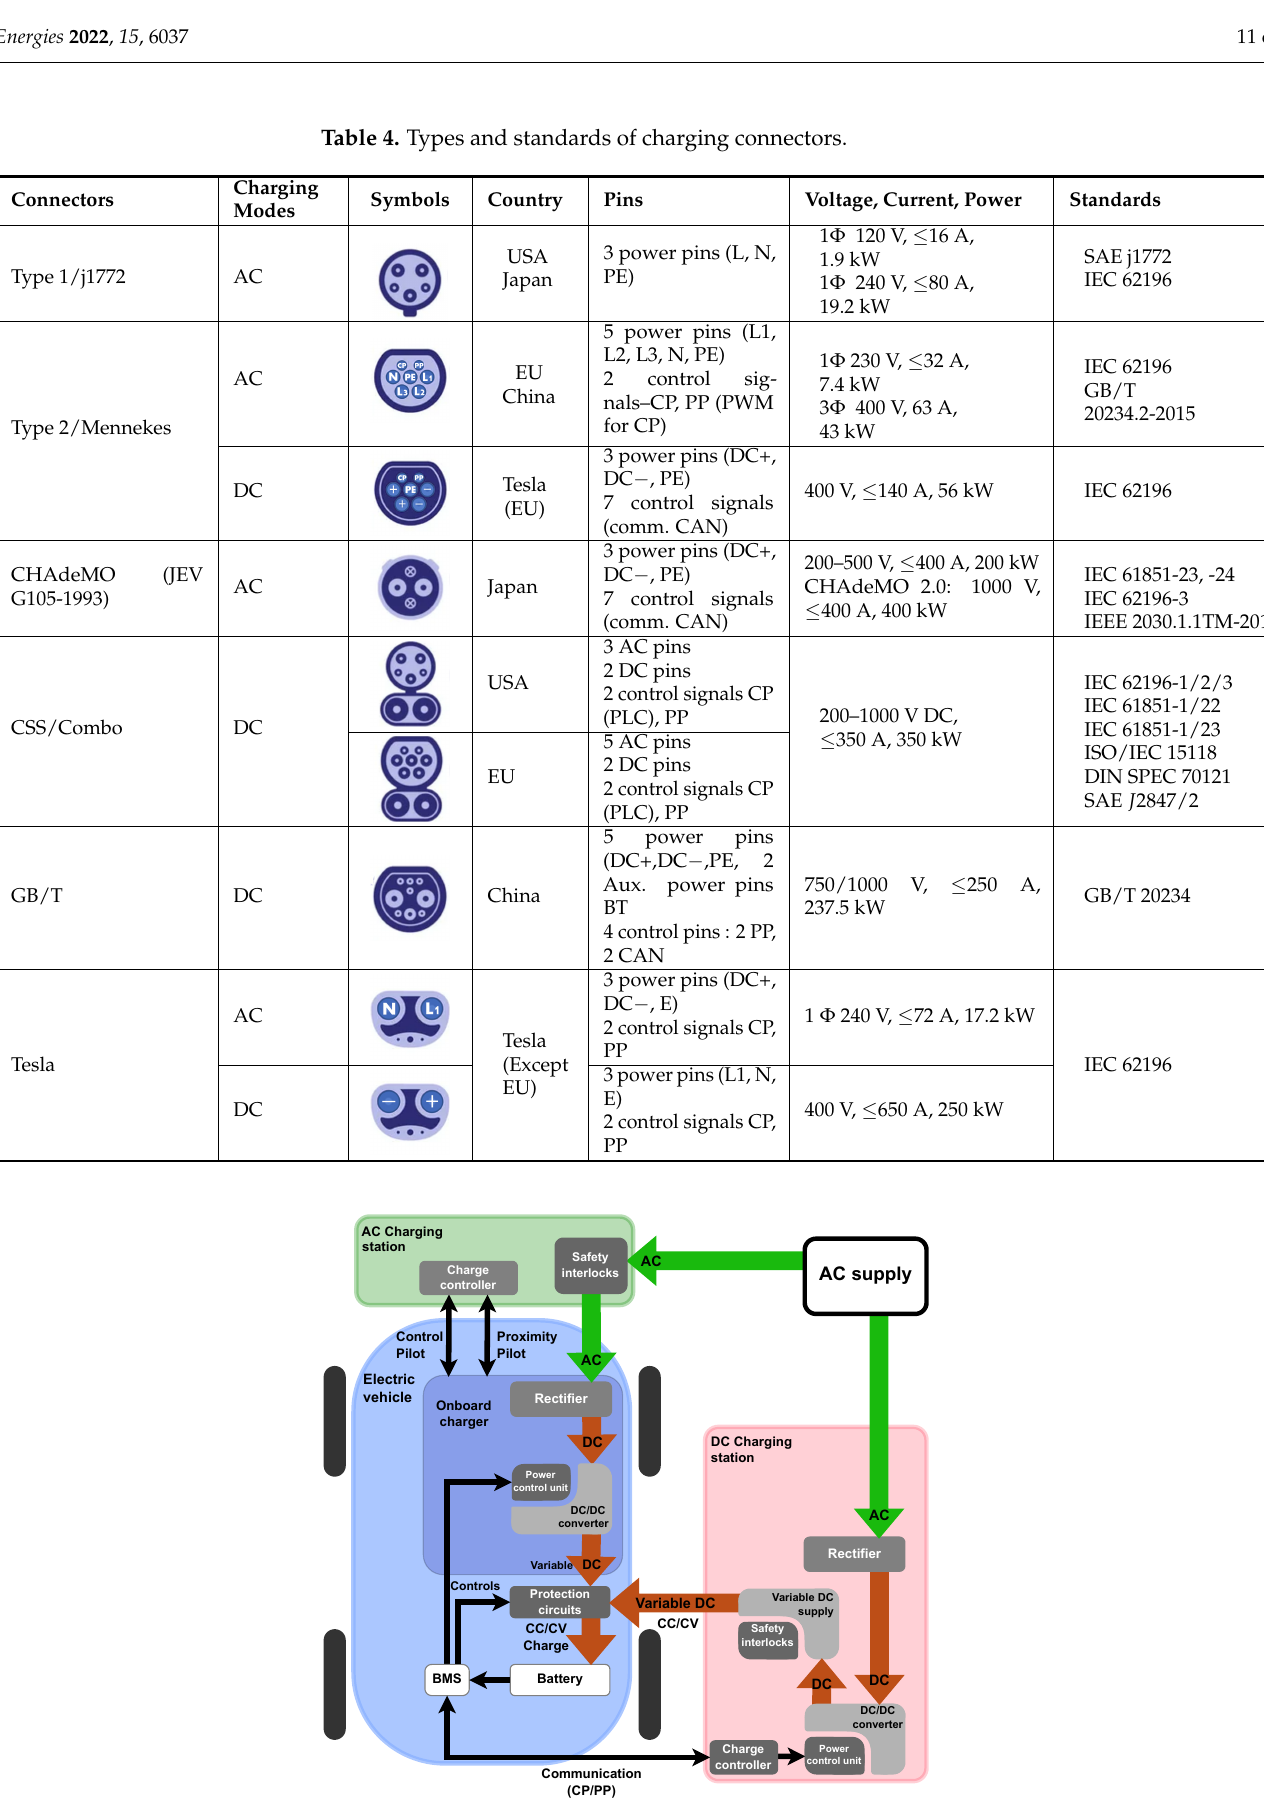
Figure 10. Electric vehicle supply